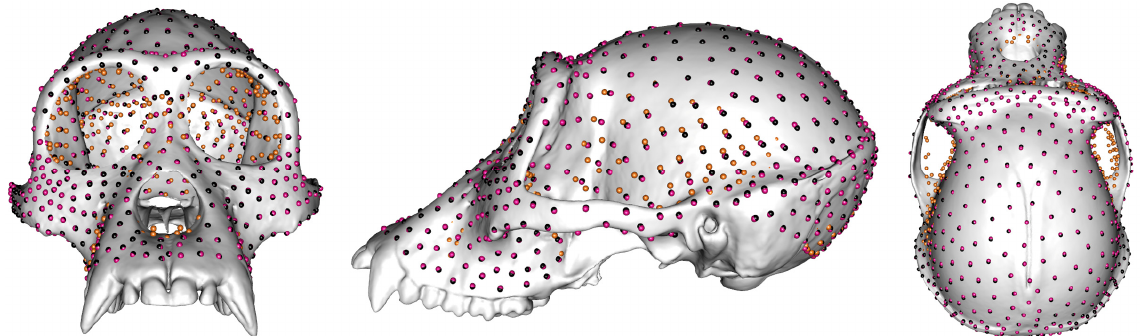
Figure 2. 800 semilandmarks generated by sliding TPS (black points), LS&ICP (amber points), and TPS&NICP (magenta points) approaches on the mean surface generated by sliding TPS. Table 1. Comparison of semilandmarks from sliding TPS and TPS&NICP approaches.